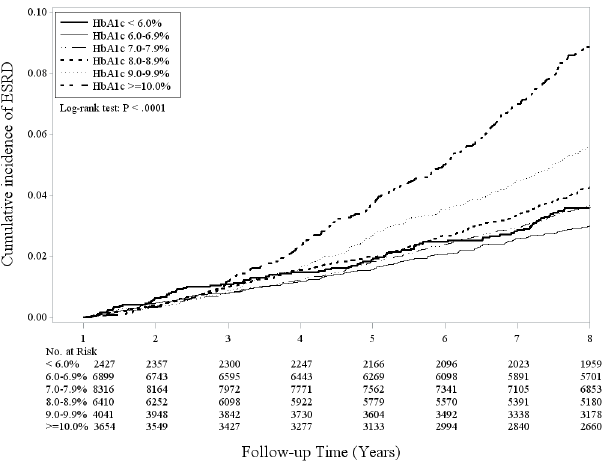
Fig 1. Cumulative incidence curves of ESRD according to clinical criteria of HbA1c levels.